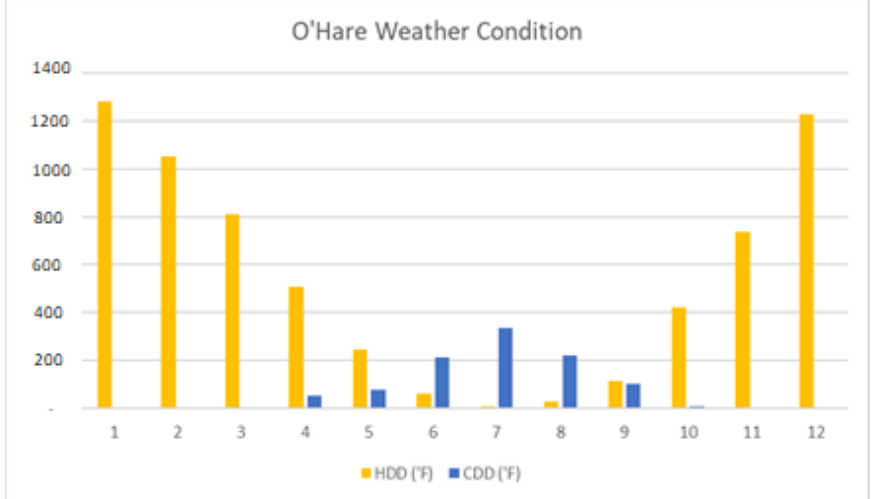
Figure 4. HDD and CDD based on the implemented weather information (°F = 1.8 × °C +32).